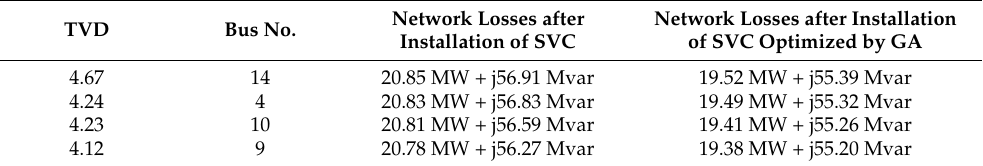
Table 6. The gain in network losses for capital saving for IEEE 14-Test-Bus Systems. Total network losses after installation of SVCs for j = 2 in four buses (candidate buses) Total network losses after installation of SVCs optimized by GA 77.80 MW The gain in power loss (i.e., Difference of losses after SVCs installation of SVCs and optimized by GA) Total Capital Saving (For 1 Year) = Unit cost (INR) × Total Energy Saving in 1 year